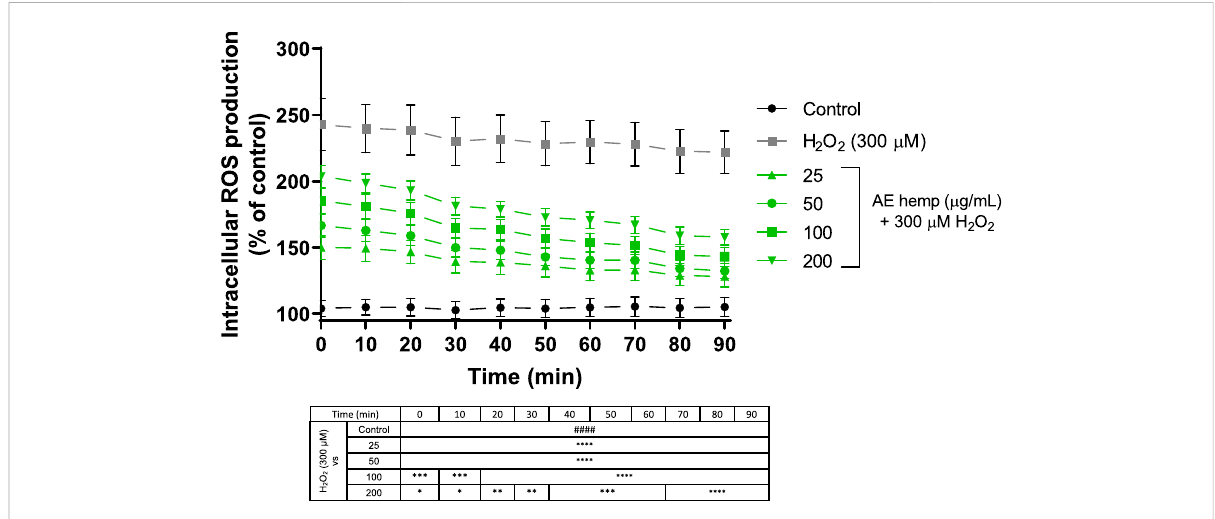
FIGURE 4 ROS production in Neuro-2a cells subjected to oxidative stress by hydrogen peroxide ((300 µM) and treatments with Cannabis sativa aqueous extract (25 – 200 μ g/ml). Data are expressed as percentage over control cells and the assay was carried out for 90 min in order to measure intracellular ROS production. Note: #### p < 0.0001 versus control. Signi fi cant differences appeared at the starting point for H 2 O 2 -N2a cells over controlcells.Since0min,25and50 μ g/mlpre-treatmentswereassociatedwithsigni fi cantdifferences( p < 0.0001).However,100and200 μ g/ ml pre-treatments were associated with signi fi cant differences ( p < 0.0005 and p < 0.05, respectively). From 70 min and above, highest signi fi cant differences were reached ( p < 0.0001) for all treatments against hydrogen